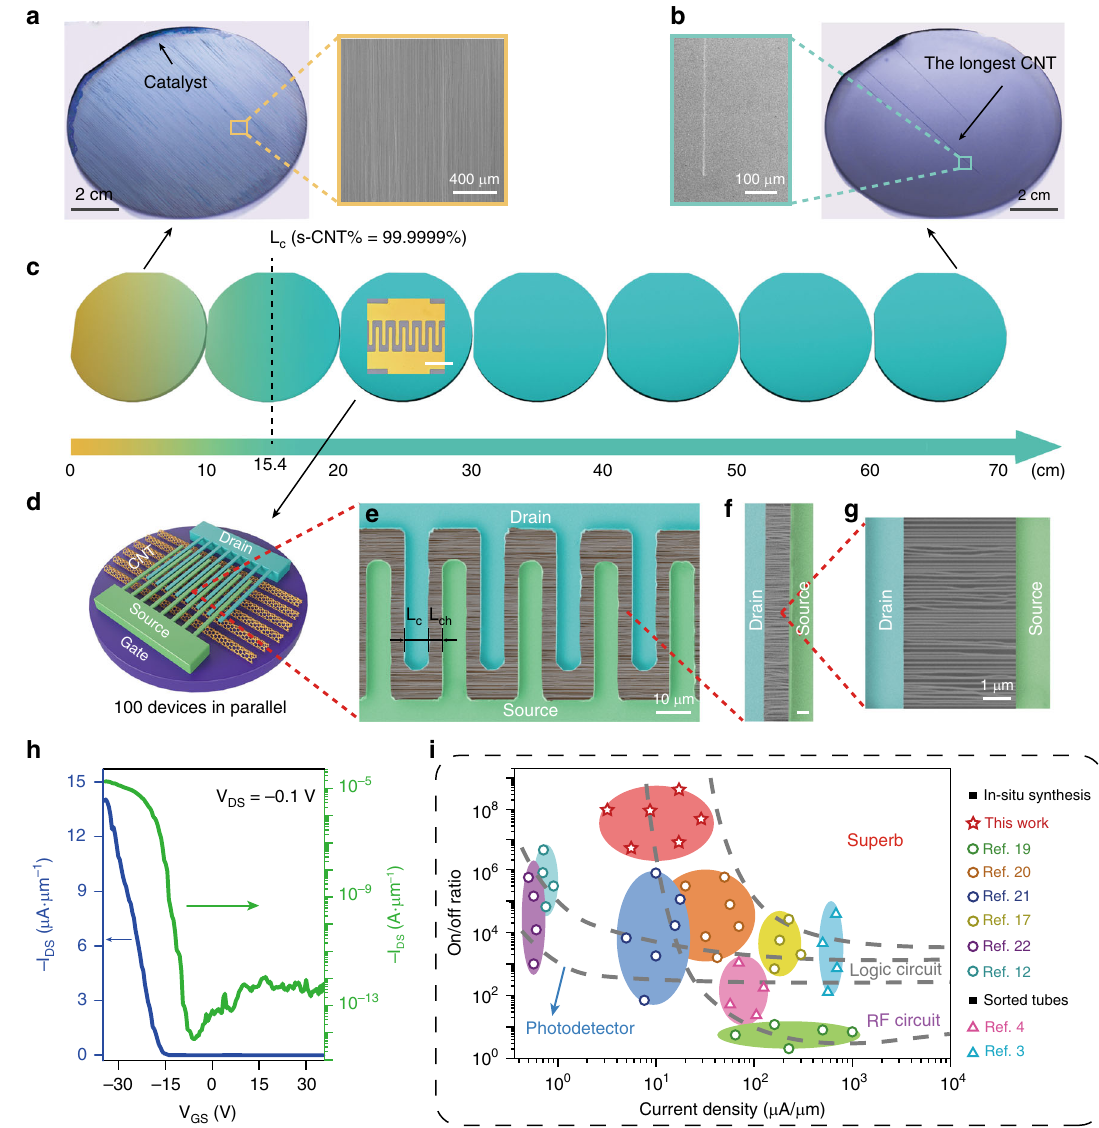
Fig. 2 Device fabrication with highly pure s-CNTs. a , b Vapor-condensation-assisted optical microscopy 38 for the CNTs synthesized on sequentially placed Si/SiO 2 wafers (diameters ~100 mm), 1st for ( a ) and 7th for ( b ). Beside panels are expanded scanning electron microscope (SEM) views from the rectangular areas. c Schematic depicting the obtainment of ultrapure aligned s-CNTs. Tubes on the left wafer in yellow contain more metallic components, whose content is indicated by the yellow brightness. At the critical length L c = 154 mm, 99.9999% pure s-CNTs can be obtained. Inset, the optical image of the interdigitated device. Scale bar, 40 μ m. d – g A prototypical interdigitated transistor fabricated on ultrapure s-CNTs, with a nominal channel length ( L ch ) of 4 μ m and contact length ( L c ) of 8 μ m. Explicit device structures are magni fi ed in e – g . Scale bar, 2 μ m in ( f ). h Transfer characteristics of the width- normalized transistor for a single channel plotted in both linear (blue, left axis) and logarithmic (green, right axis) scales with applied V DS of -0.1 V. i Benchmarking the width-normalized device fabricated on ultralong CNT arrays for a single channel with those previously reported. The standards for various applications are derived from the proposal of IBM 7 , by transforming the target parameters (density and purity of s-CNTs) into measurable